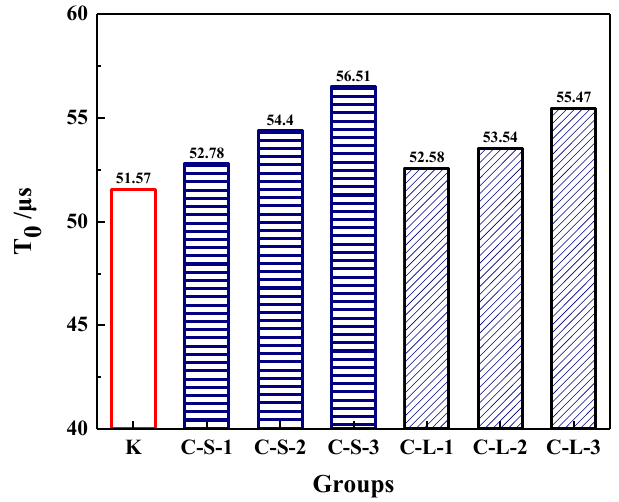
Figure 18. Pulse time of mortar preloading.